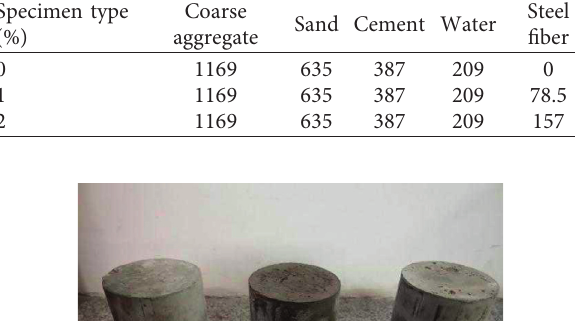
Figure 4: Test specimens immersed in storage box.